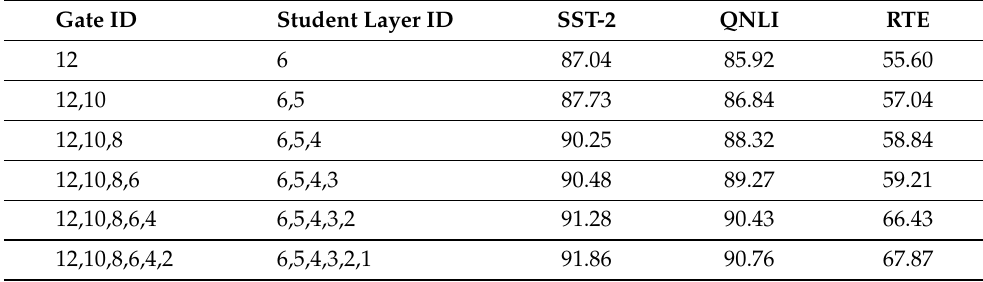
Table 6. Performance comparisons of transferring different extent of aggregated internal